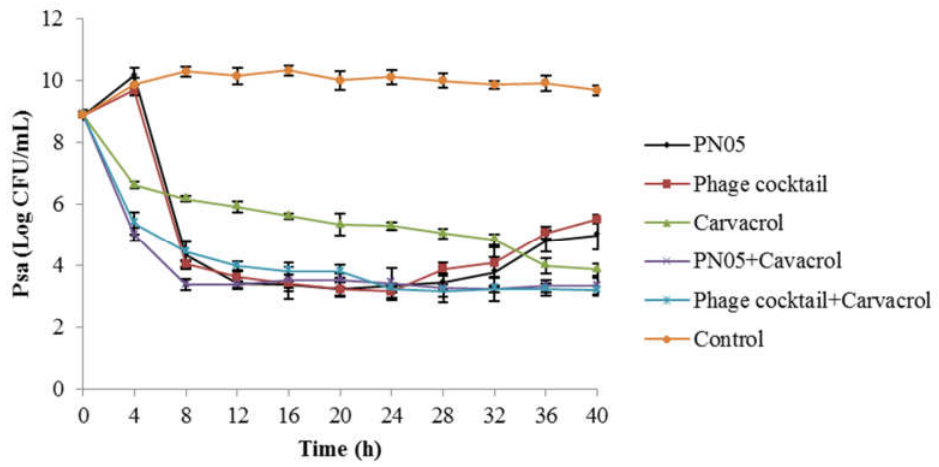
Figure 5. Inactivation of Psa (SCJY02-1) by phage PN05, phage cocktail and carvacrol. Data are the mean ± standard deviation of three independent assays.